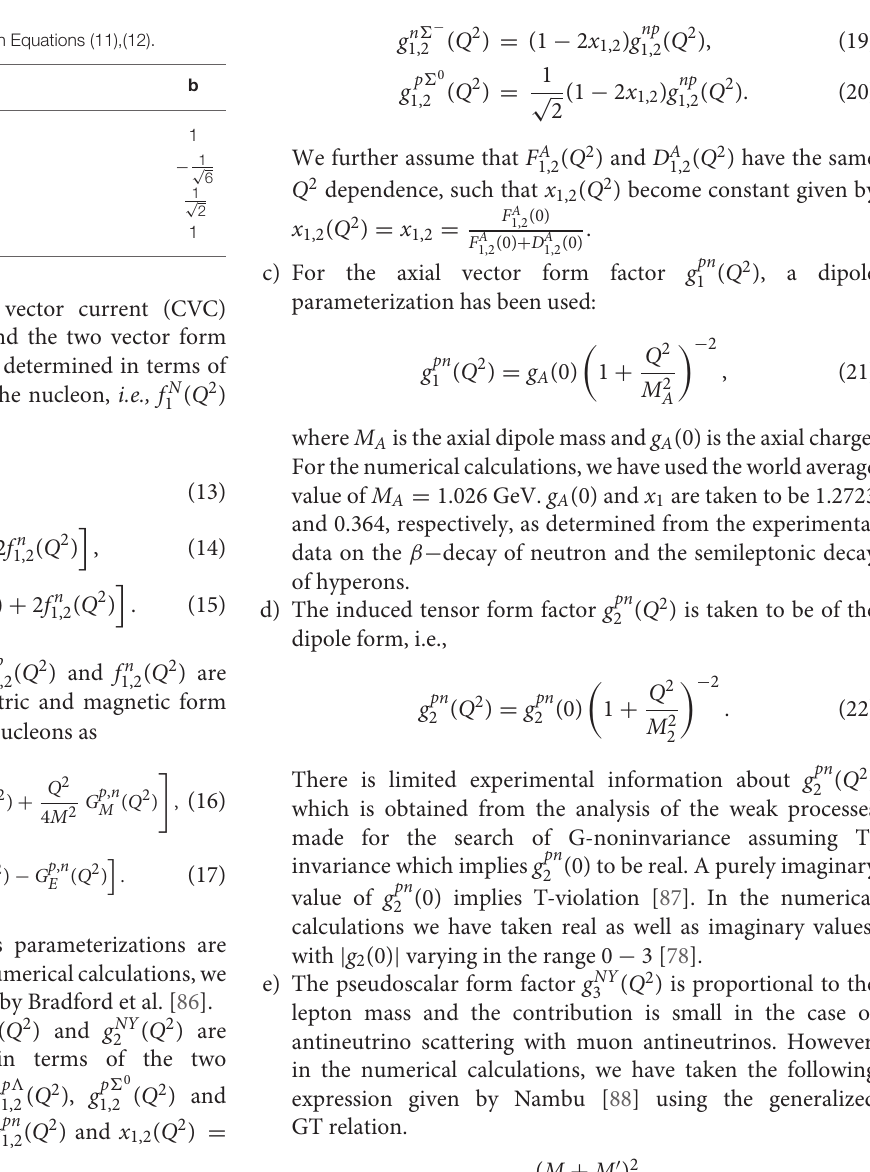
FIGURE 1 | Feynman diagram for the processes (A) represent four momenta of the corresponding particles. N stands for a n or p , Y may be a 3 or 6 0 or 6 − and the 1 may be a 1 0 or 1 − depending upon the initial nucleon state.